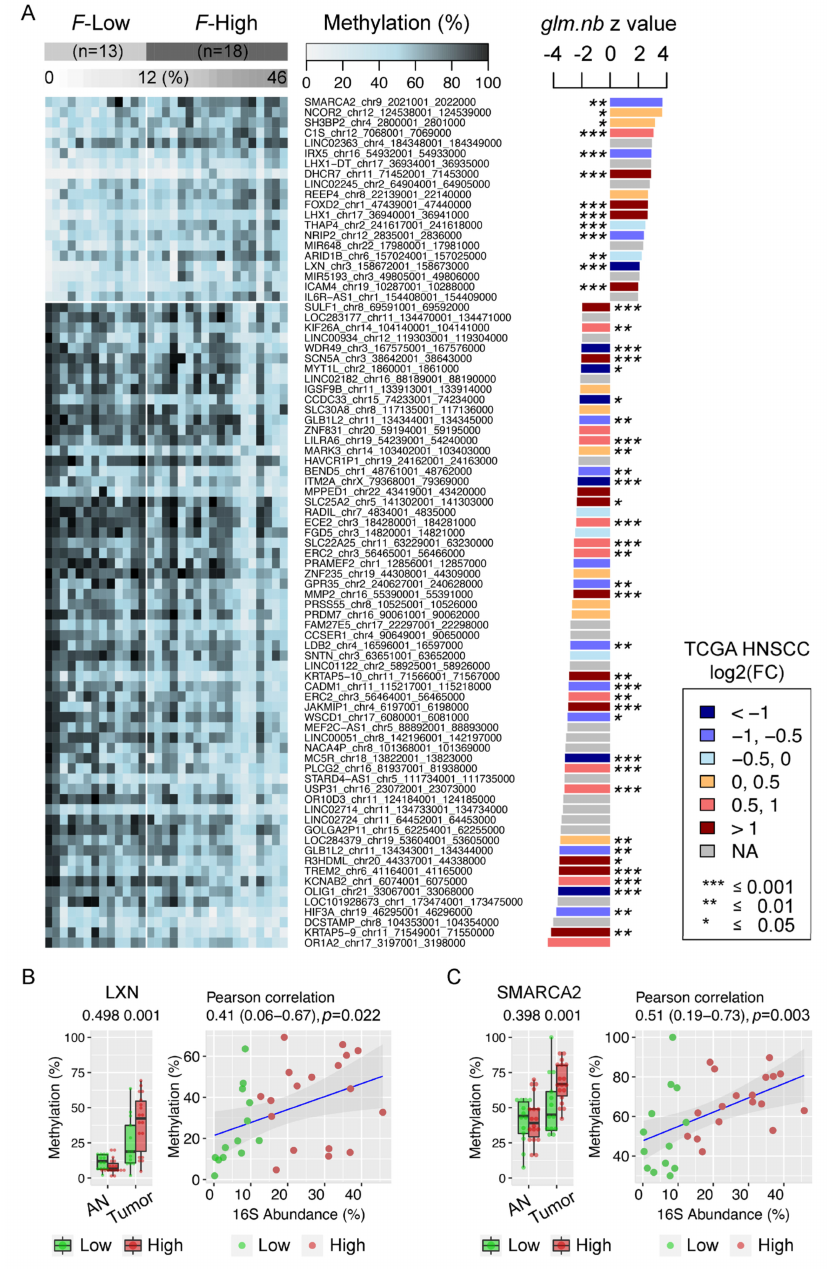
Figure 5. Bisulfite DNA capture sequencing demonstrating di ff erentially methylated human gene promoters in Fusobacterium -enriched HNSCC tumor tissues. ( A ) A heat map of methylation profiles of host gene promoters between Fusobacterium -high ( F -High) and Fusobacterium -low ( F -Low) HNSCC tumor tissues. Negative binomial generalized linear regression model z values ( glm.nb , p ≤ 0.05) are shown in the right panel of the heat map, with colors indicating gene expression changes (log2FC) in the TCGA HNSCC cohort. ( B ) Positive correlation between Fusobacterium enrichment and TSG- LXN promoter hypermethylation in HNSCC tumor tissues. ( C ) Positive correlation between Fusobacterium enrichment and TSG- SMARCA2 promoter hypermethylation in HNSCC tumor tissues. AN: adjacent normal tissues. Tumor: HNSCC tumor